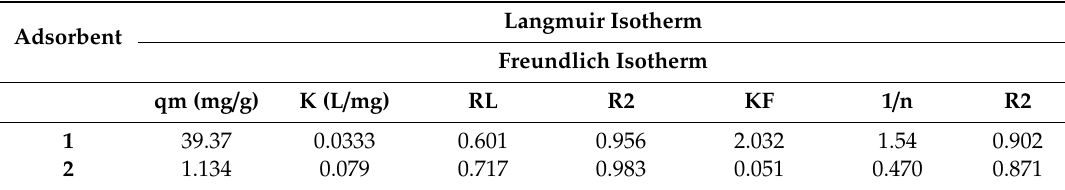
Table 5. Coe ffi cients of two di ff erent sorption isotherm models for Pb(II) removal by adsorbents 1 and 2 and their correlation coe ffi cient (R 2 ). (Experimental conditions: dosage = 0.015 g (adsorbent 1 ) and